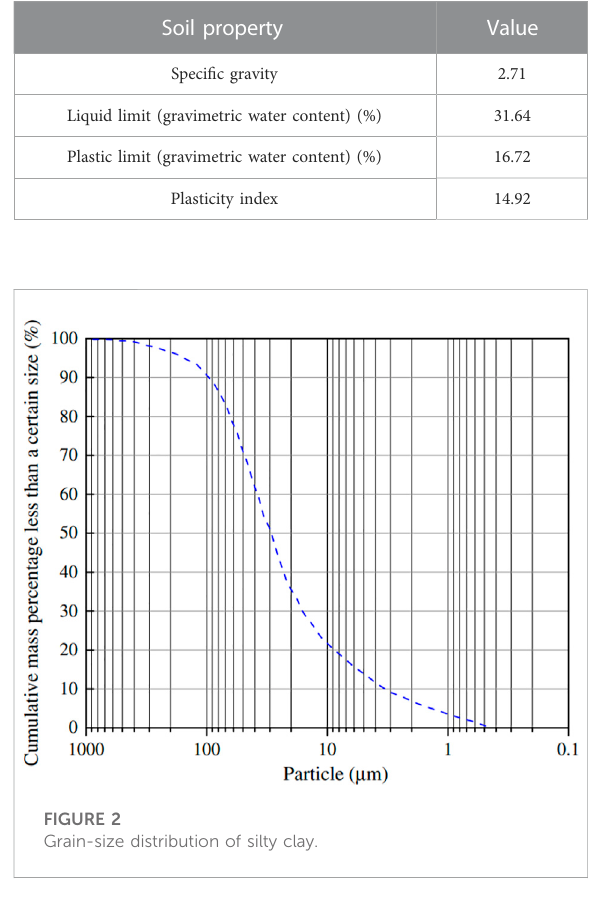
FIGURE 2 Grain-size distribution of silty clay.